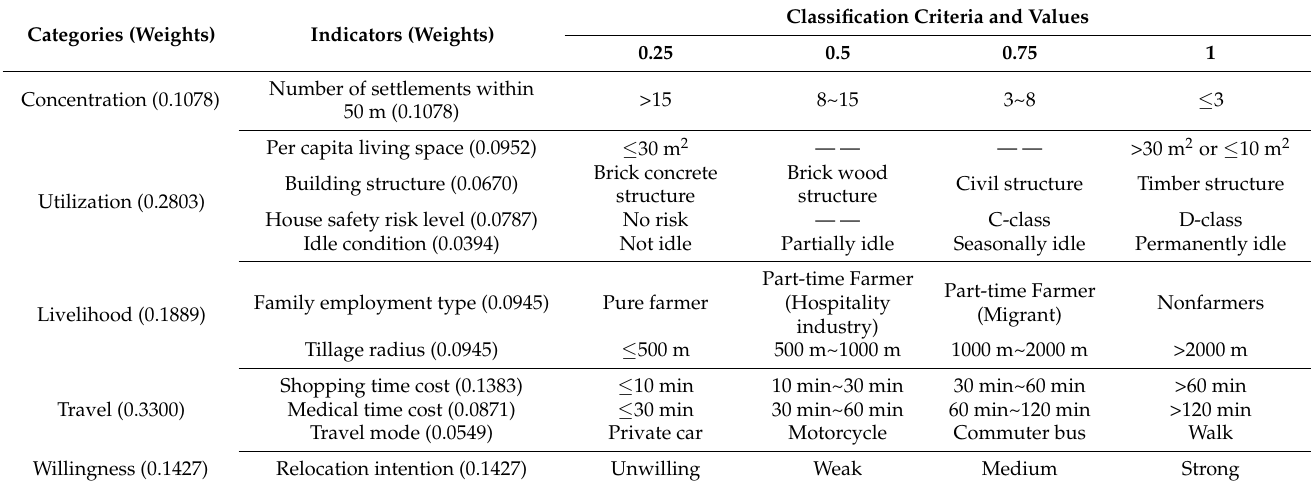
Table 4. Index system for evaluating the reconstruction urgency of rural